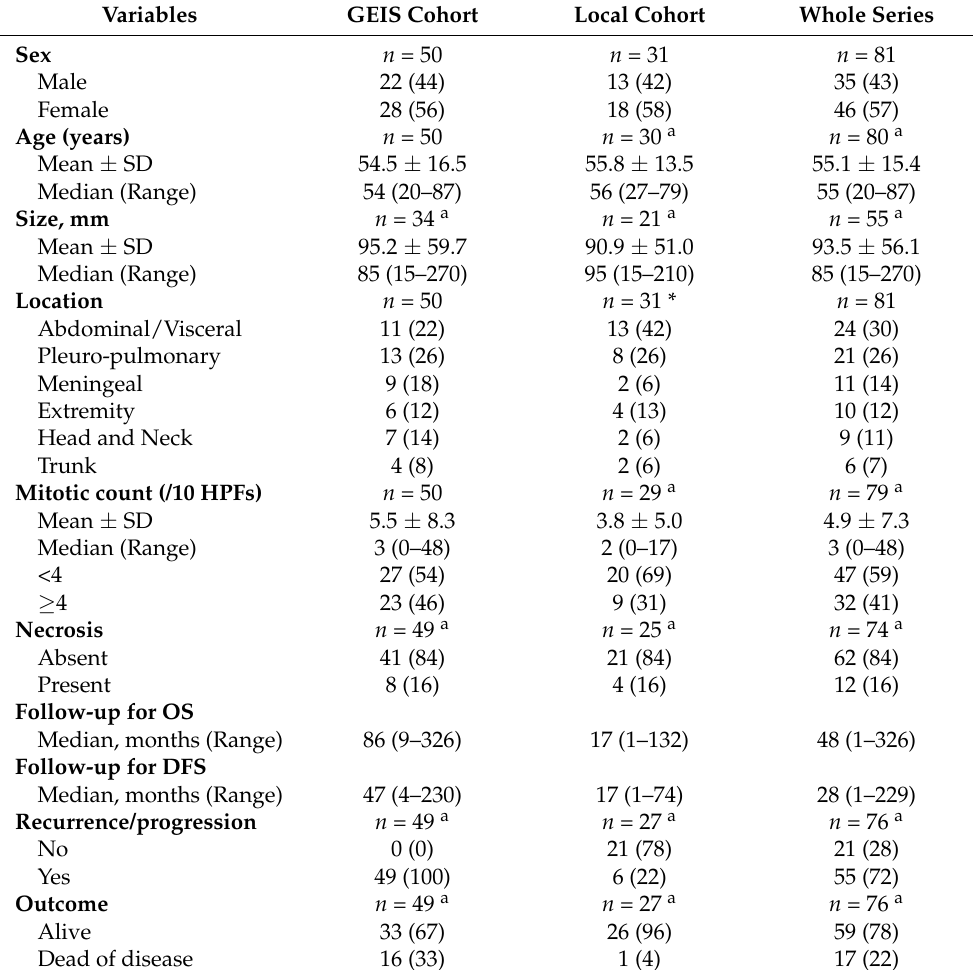
Table 1. Clinicopathological features and outcome of patients with solitary fibrous tumors in each